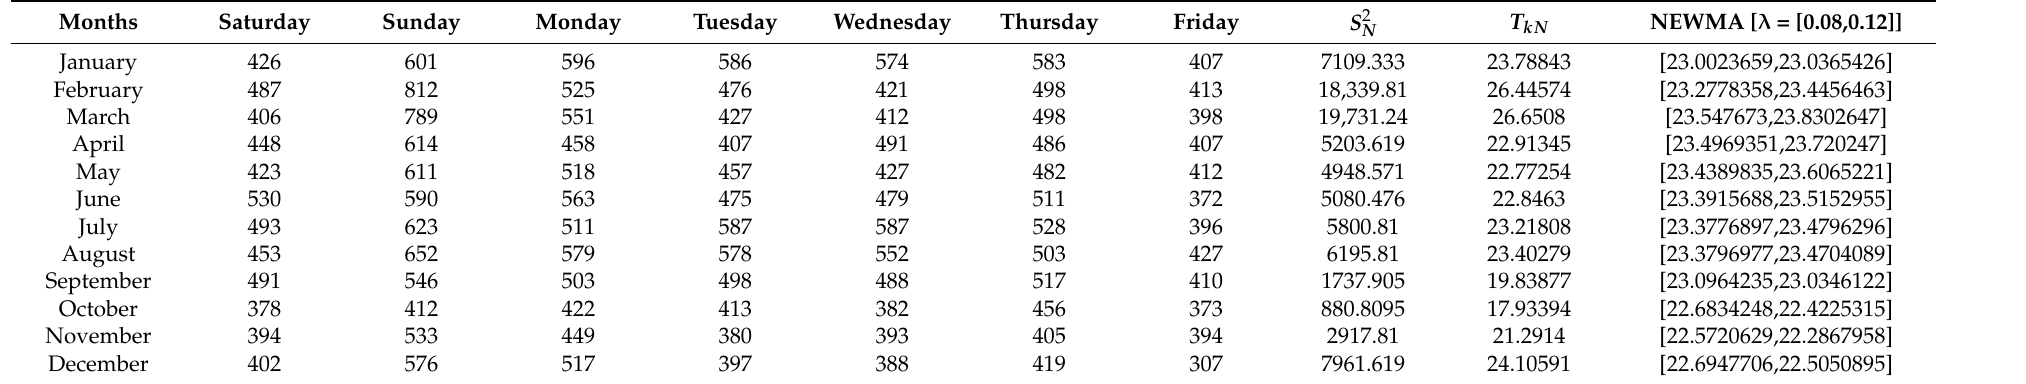
Table 9. Accident Data in